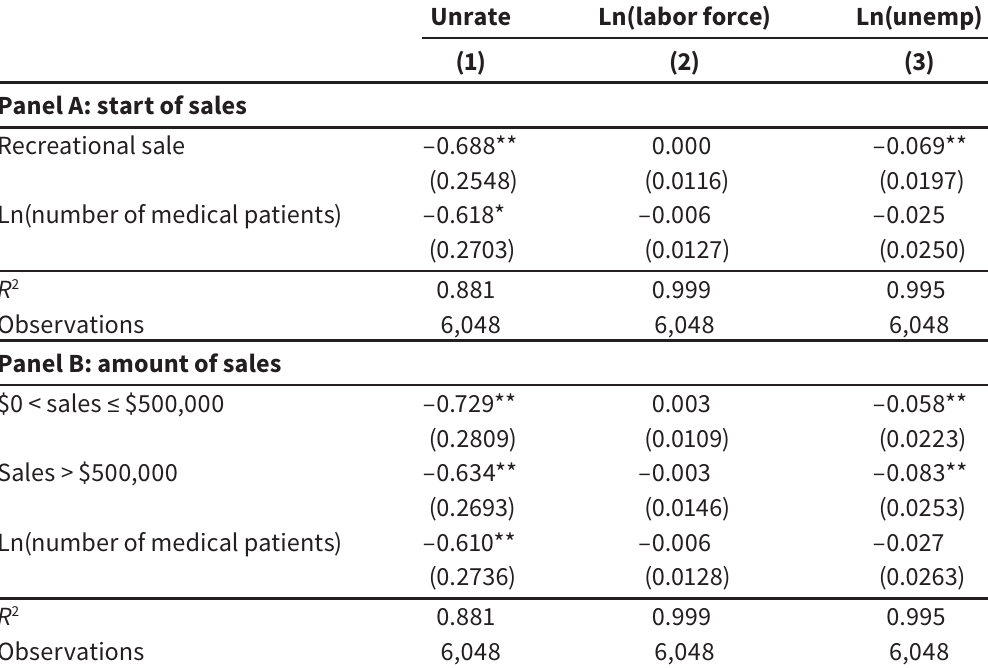
The effect of recreational dispensary entry on the unemployment rate ( Unrate), Ln(labor force), and Ln(unemployed) – regression